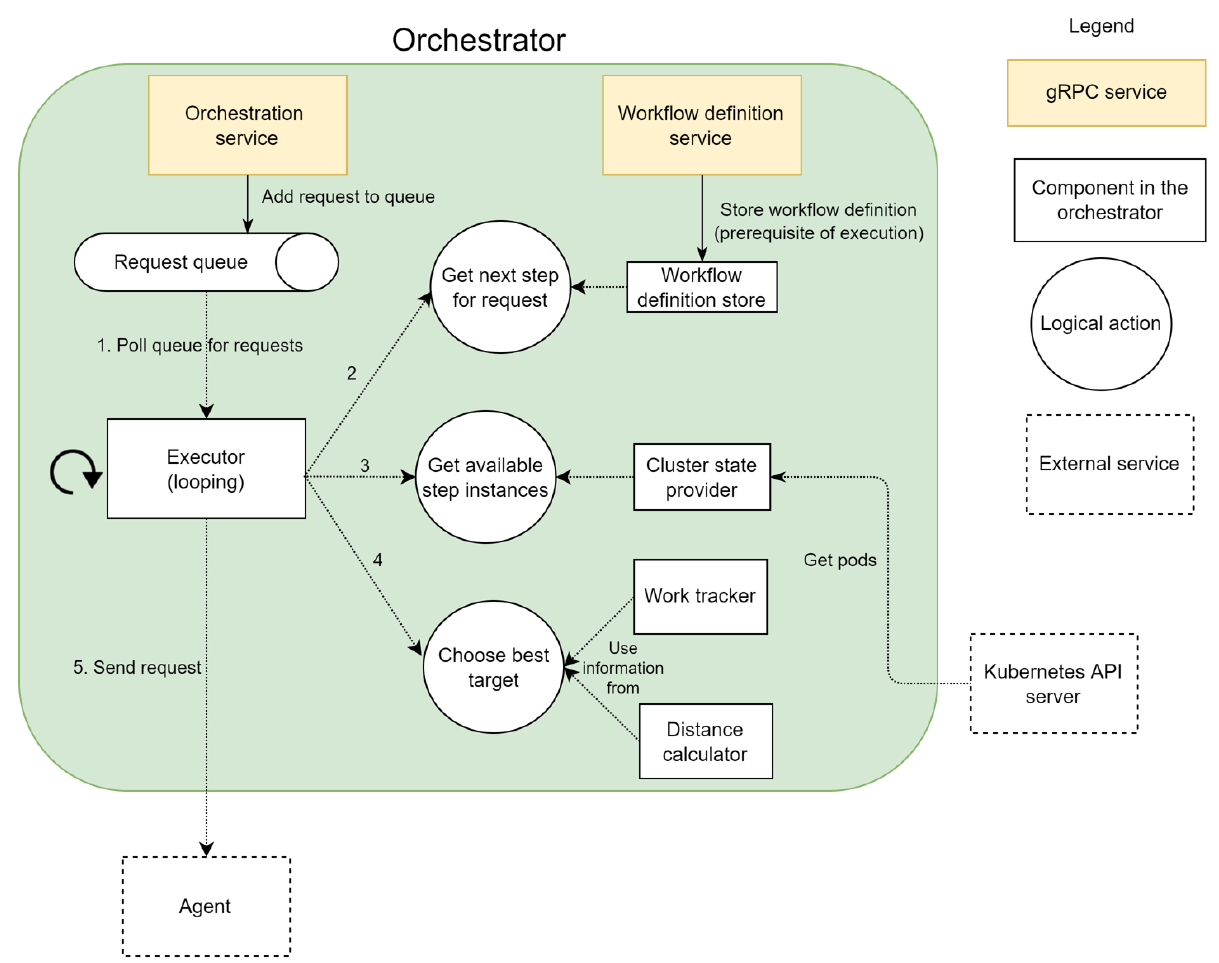
Figure 4. An overview of the orchestrator